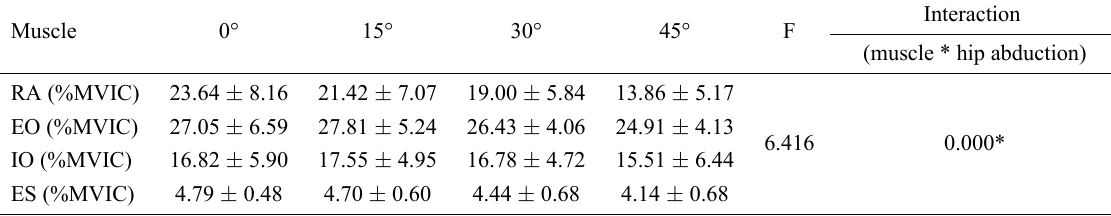
Table 2. Interaction of hip joint abduction angle and muscles during plank exercise.